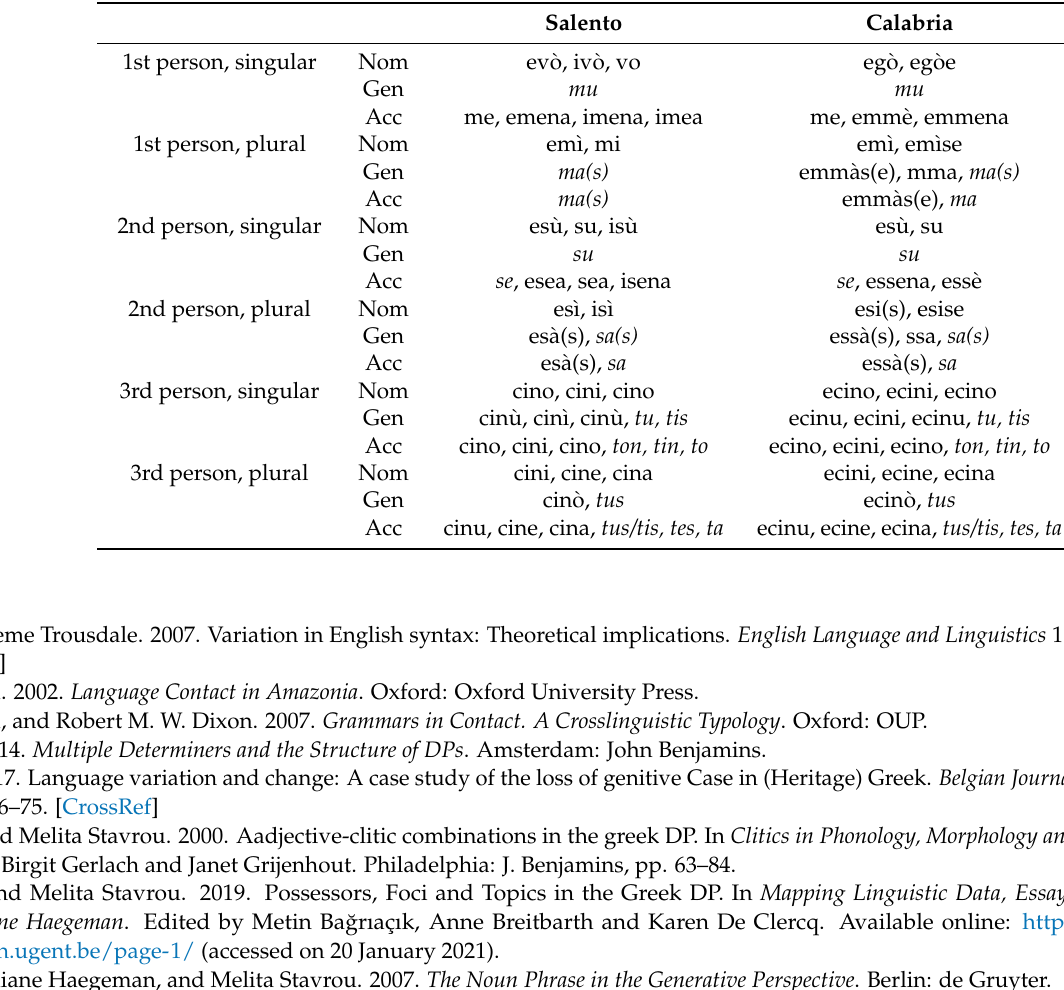
Table A1. Personal pronouns in Italiot Greek 51